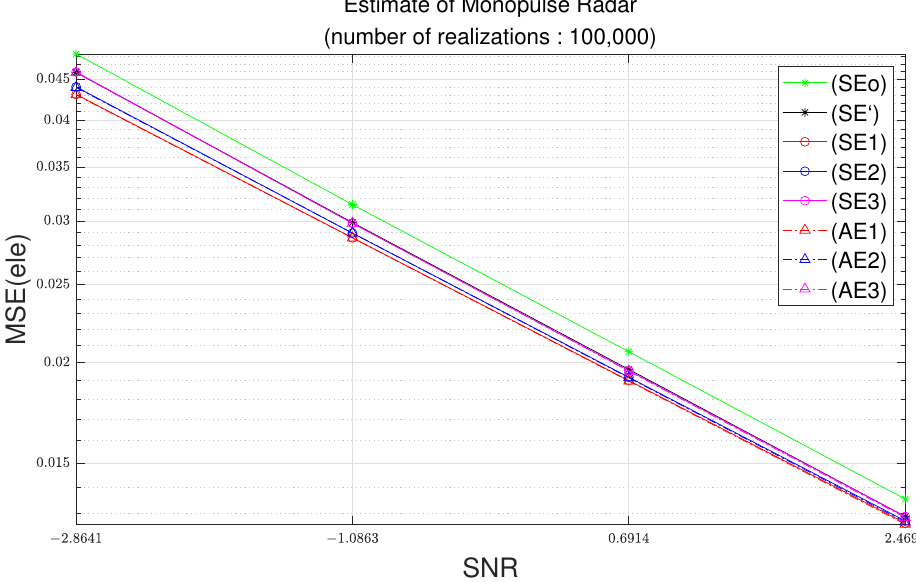
Figure 6. Elevation MSE as function of SNR with parameters of Table 2 and 100,000